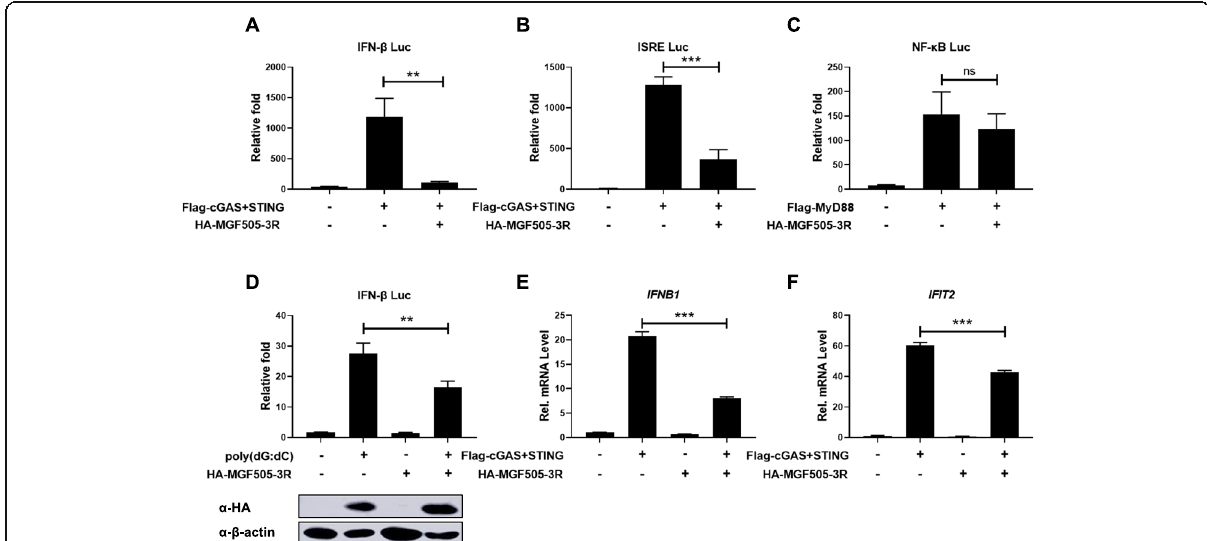
Fig. 1 MGF505-3R inhibited the cGAS-STING-mediated IFN- β signaling pathway. A-C HEK293T cells were cotransfected with IFN- β promoter, ISRE, or NF- κ B luciferase reporter plasmids (100 ng); pRL-TK plasmid (50 ng) and the indicated plasmids (200 ng) (pCMV-N-HA was chosen as a negative control). Twenty-four hours after transfection, HEK293T cells were used for dual-luciferase reporter assays. D Twenty hours after transfection of HA-MGF505-3R, the cells were left untreated or treated with poly (dG:dC) (500 ng) for 12 h before use in dual-luciferase reporter assays. MGF505-3R expression was analyzed by western blotting using an anti-HA antibody. E-F HEK293T cells were transfected with the Flag- cGAS/Flag-STING expression plasmids (500 ng) and HA-MGF505-3R expression plasmid (1 μ g). Twenty-four hours after transfection, the cells were used for qRT – PCR analysis. “ + ” represents transfected, “ - ” represents nontransfected. All experiments were repeated independently at least thrice. The data from independent experiments are presented as the mean ± SD; n =3. * P <0.05, ** P <0.01, *** P